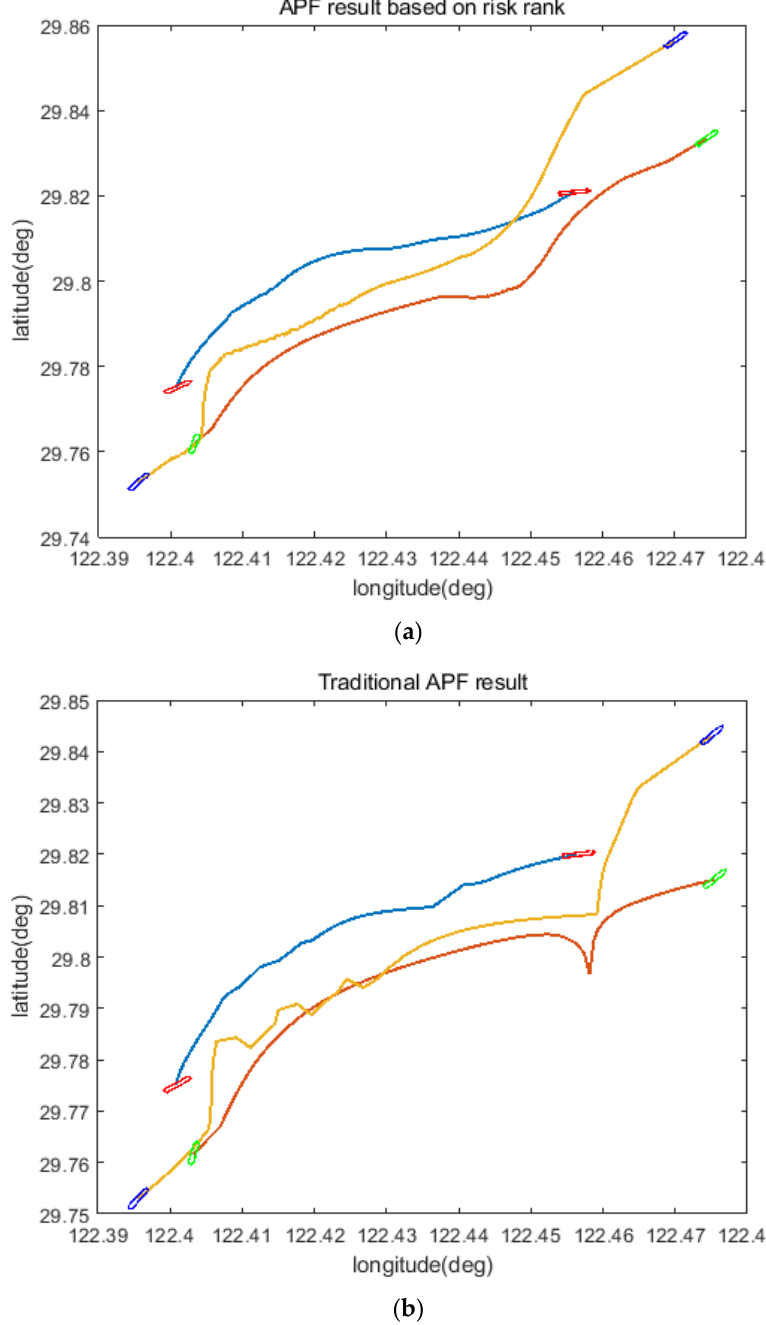
Figure 19. Artificial potential field result based on risk rank ( a ); traditional artificial potential field result ( b ).